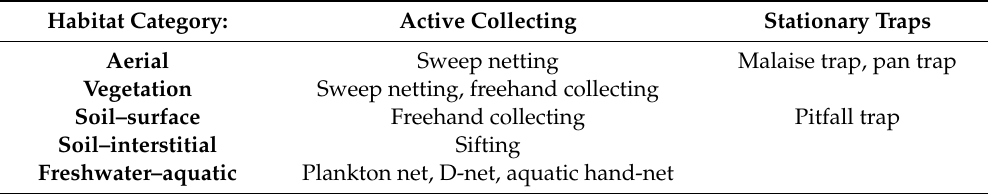
Table 1. Types of collecting methods used and the habitat categories they targeted. Habitat Category: Active Collecting Stationary Traps Aerial Sweep netting Malaise trap, pan trap Vegetation Sweep netting, freehand collecting Soil–surface Freehand collecting Pitfall trap Soil–interstitial Sifting Freshwater–aquatic Plankton net, D-net, aquatic